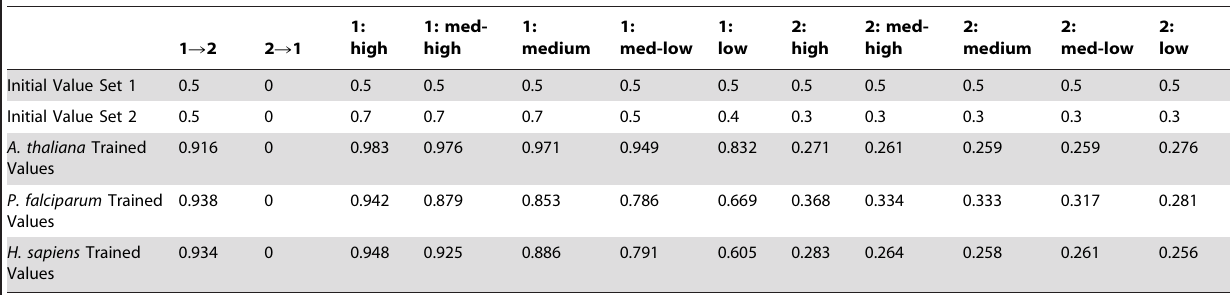
Table 1. HMM Parameter